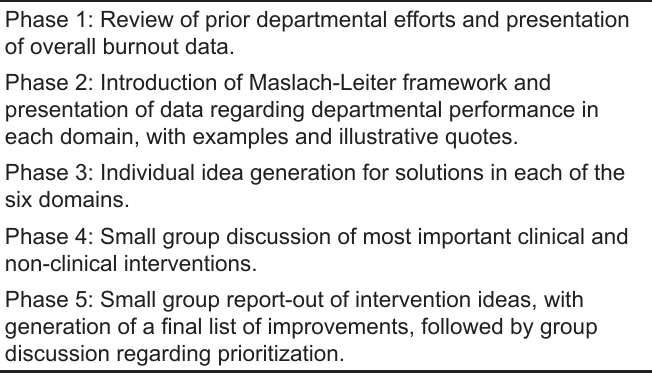
Table 2. Phases of the two-hour facilitated discussion session on burnout, organized by